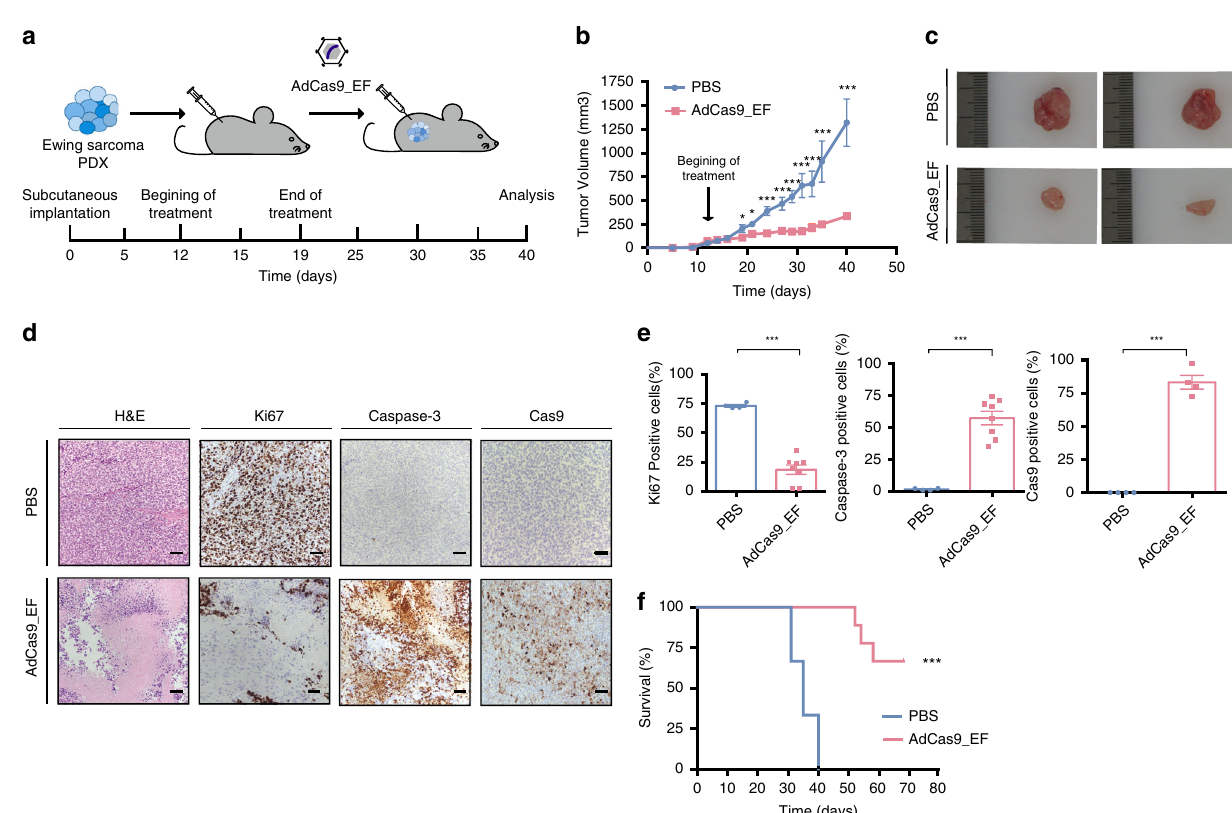
Fig. 4 Deletion of EWSR1-FLI1 inhibits tumor growth in PDX models. a Diagram showing the approach for the AdV-based in vivo treatment. PDXs were implanted into immunosuppressed mice and tumors were allowed to develop (~150 mm 3 in size). Tumors were then injected with AdCas9_EF edition vector or PBS control vector at days 12, 14, 16, and 19. Mice were sacri fi ced when tumor volume reached 1500 mm 3 . b Tumor growth over the 40 days following subcutaneous PDX implantation. (PBS n = 3; AdCas9_sgEF n = 9 animals) (*** p = 3e-5). c Representative tumors of control and experimental mice sacri fi ced 40 days after PDX implantation. d Representative images of histological H&E staining, Ki-67, caspase-3, and Cas9 immunostaining of A673 experimental and control cells. Scale bars, 500 μ m (4×) or 50 μ m (20×). e Percentage of Ki-67-(*** p = 3e-6), caspase-3-(*** p = 3e-5) and